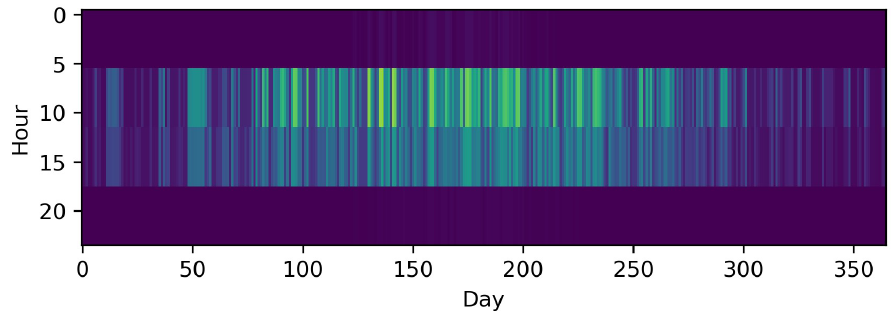
Figure 5. The time series of photovoltaic capacity factors downsampled to 1460 6 h time steps.